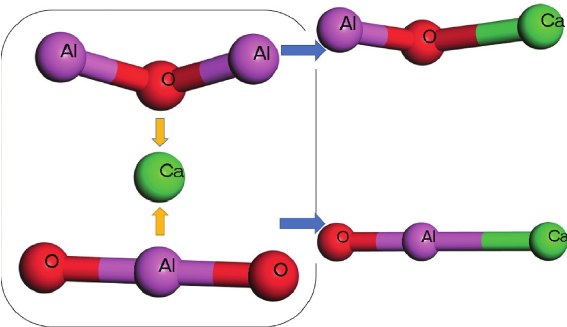
Figure 7: Schematic diagram for the changes of the network.